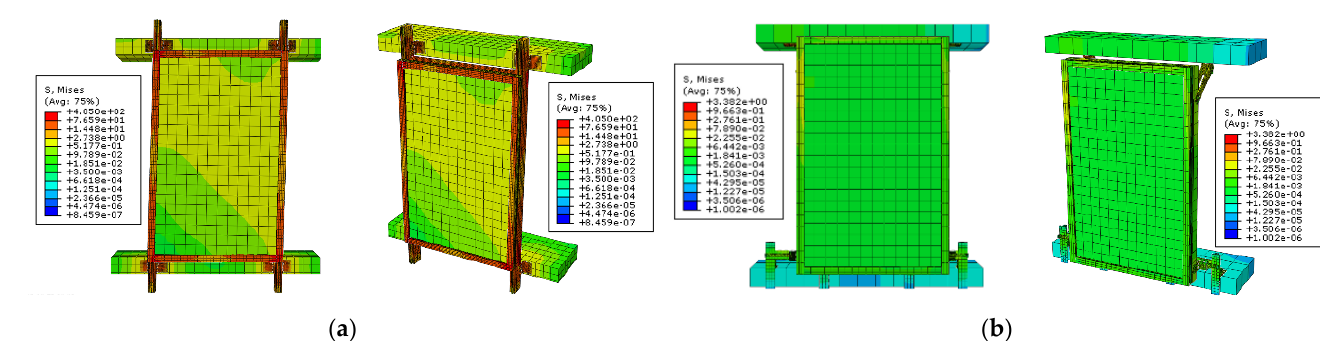
Figure 26. Comparison of appearance changes under applied X -axis inter-story drift: ( a ) non-seismic curtain wall module; ( b ) seismic curtain wall module.